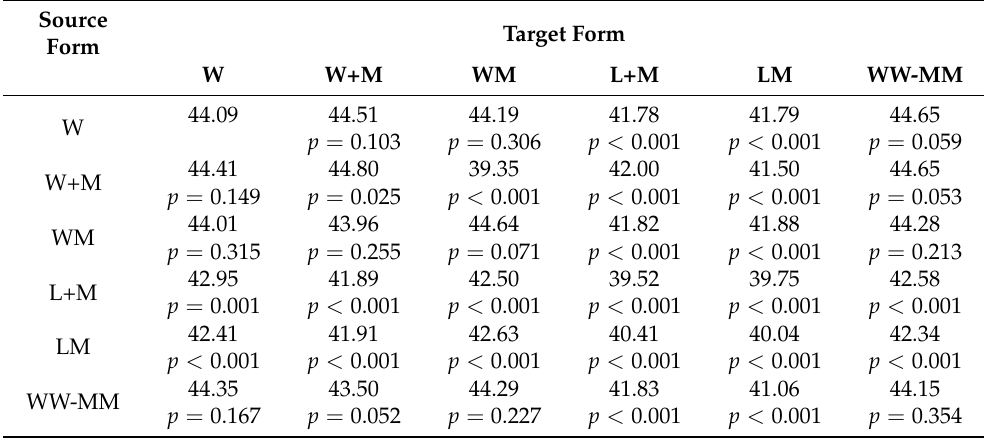
Table 10. BLEU scores and p -values for the translations from English to Slovene for different systems on the ParaCrawl corpus.